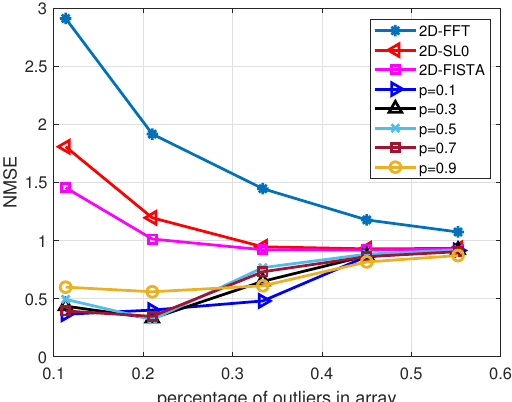
Figure 6. The relationship between the percentage of outliers and the